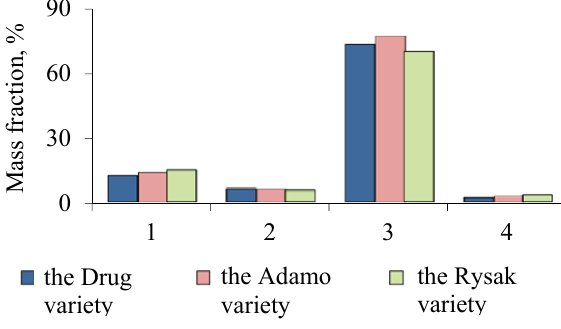
Fig. 1. Chemical composition of oat grains: (1) the mass fraction of protein, %; (2) the mass fraction of fat, %; (3) the mass fraction of carbohydrates, %; (4) the mass fraction of ash, %.